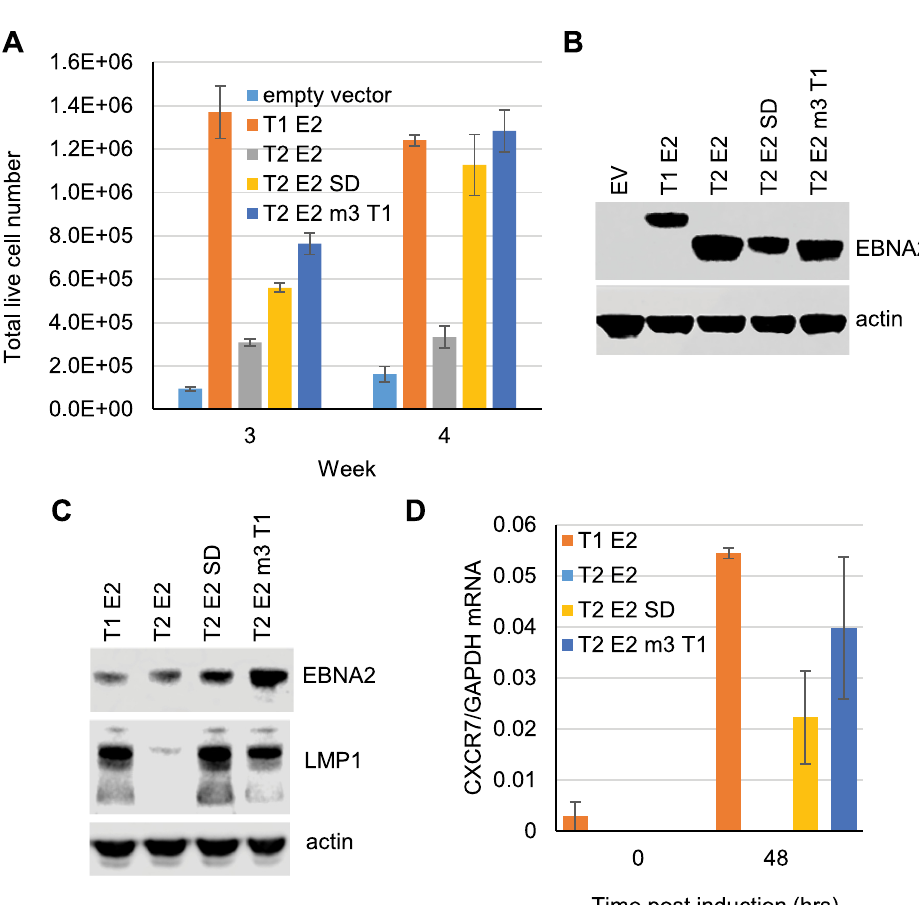
Fig 7. LCL growth maintenance assay using type 2 EBNA2 mutants. (A) ER-EB 2.5 cells conditionally expressing an estrogen receptor type 1 EBNA2 fusion protein were cultured in medium containing β -estradiol prior to resuspension in medium without β -estradiol. Cells were transfected with OriP-based plasmids (p294) expressing full length type 1 or type 2 EBNA2 or the type 2 SD or motif 3 T1 mutant EBNA2 proteins and cultured in medium without β -estradiol. Live cells (that excluded Trypan Blue) were counted, 3 and 4 weeks post-transfection. Data from a representative experiment of 3 independent repeats is shown. Error bars show the mean ± standard deviation of triplicate cell counts for each sample. (B) Western blot analysis of EBNA2 expression in protein extracts from the transfected EREB2.5 cells. Cells were harvested 4 days after transfection. EBNA2 was detected using the PE2 monoclonal antibody and blots were probed for actin as a loading control. (C) Western blots analysis of LMP1 expression in Daudi stable cell lines carrying metallothionein promoter driven EBNA2 expression constructs. Each cell line was induced to express full length type 1 or type 2 EBNA2 or the type 2 SD or motif 3 T1 mutant EBNA2 proteins by treating with cadmium chloride for 48 hrs. EBNA2 and LMP1 were detected using the PE2 and CS1-4 monoclonal antibodies respectively and blots were probed for actin as a loading control. (D) QPCR analysis of CXCR7 transcript expression from RNA extracted from the cell lines analysed in B, before and 48 hr after induction with cadmium chloride. cDNA was amplified using CXCR7 specific primers and the signal expressed relative to